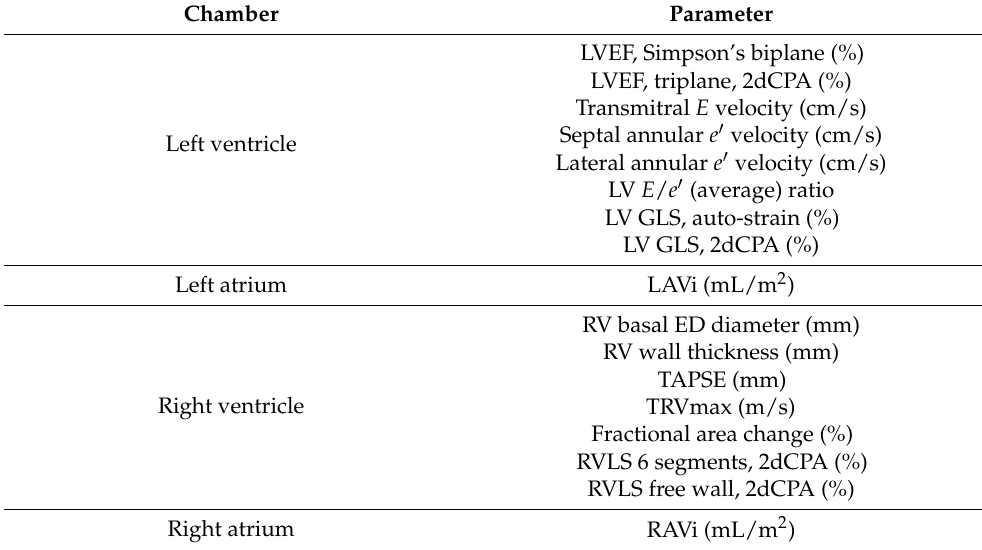
Table 1. Echocardiography derived